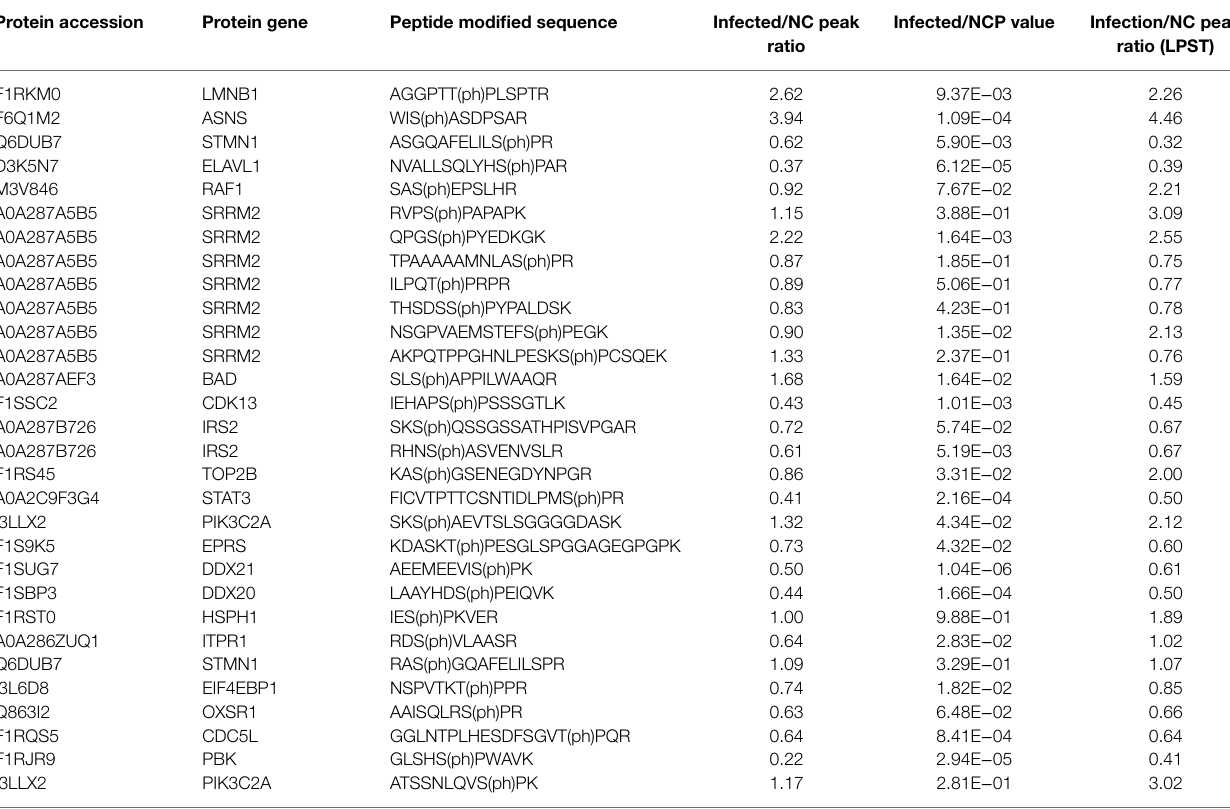
TABLE 1 | Parallel reaction monitoring (PRM) analysis and comparison of the quantitative results for candidate phosphoproteins. Protein accession Protein